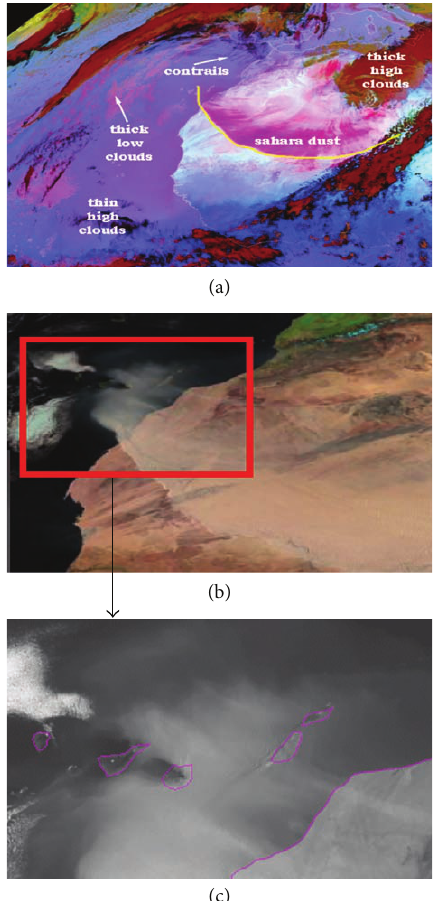
Figure 13: (a) Dust clouds from West Africa extending to Atlantic Ocean and Canary Islands, detected by (EUMETSAT) Met-8 on 3 March 2004 at 12 UTC. (b) Dust storms from the Northwest Africa and high dust concentrations above Canary Island at 18 UTC where dry deposition occurred. The reddish rectangle indicates the occurring zone of dry deposition. (c) The Zoom image above the Canary Island showing high dust concentration originating from North West Africa regions. (a), (b), and (c) are taken from Visible Earth (2004).